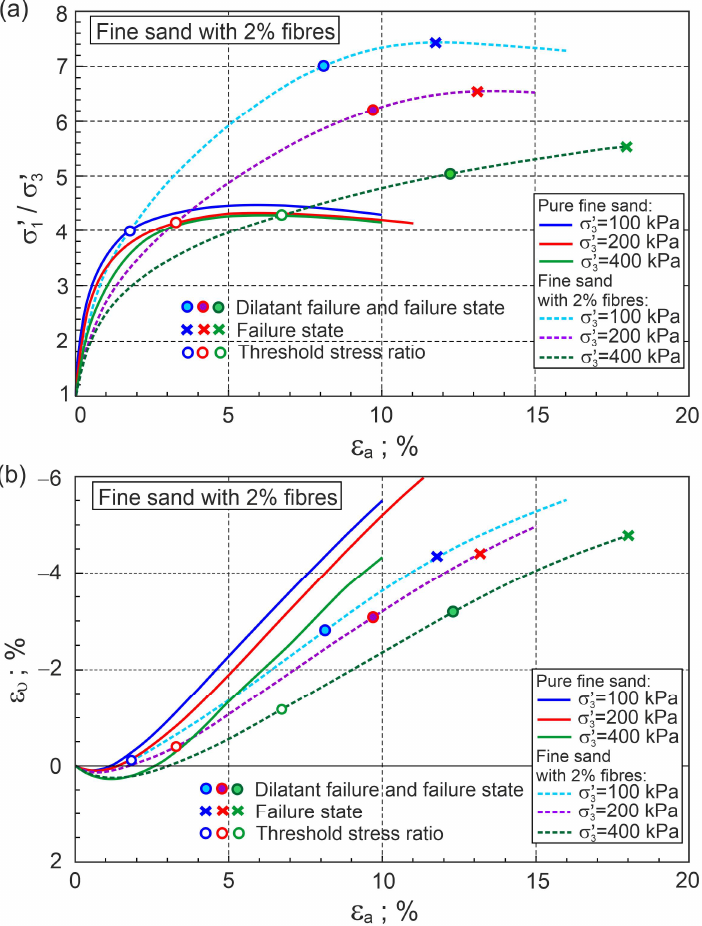
− ε a and ( b ) ε υ − ε a (experimental / σ (cid:48) 3 1